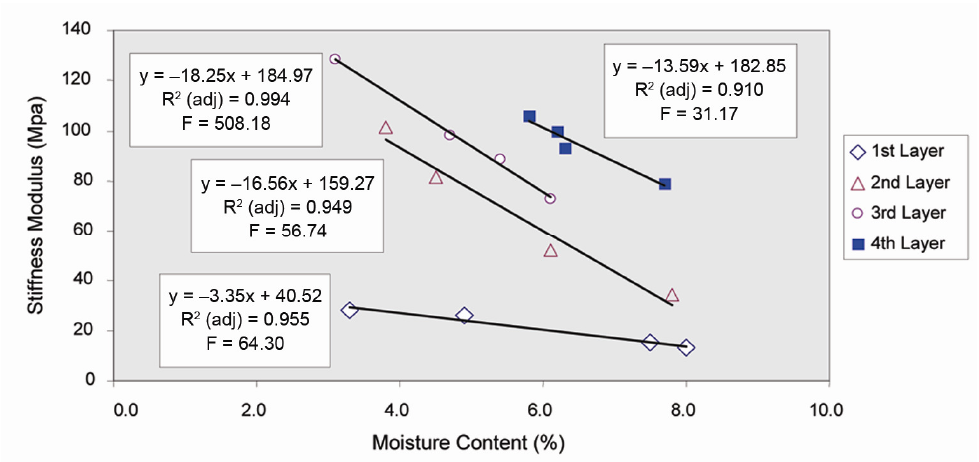
Fig. 7. Variation of stiffness modulus versus moisture content in different layers